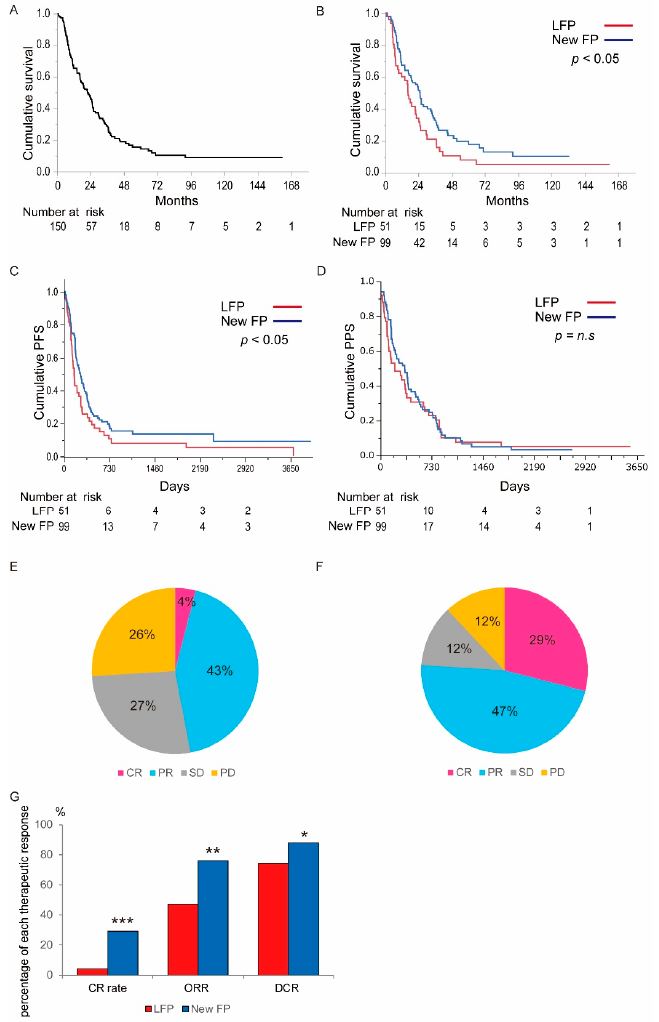
Figure 2. The therapeutic outcomes of LFP and New FP. ( A ) Overall survival curve of the 150 patients treated with either LFP or New FP. The MST of 150 patients was 21.8 months. ( B ) Comparison of the survival curve between LFP and New FP group. The MST of LFP group was 16.1 months. The MST of New FP was 24.7 months. There was a significant difference between two groups ( p < 0.05). ( C ) Comparison of Progression-free survival between LFP and New FP group. The PFS of LFP group was 5.4 months. The MST of New FP was 8.8 months. There was a significant difference be- tween two groups ( p < 0.05). ( D ) Comparison of the post-progression survival between LFP and New FP group. The PPS of LFP group was 6.8 months. The PPS of New FP was 11.5 months. There was no significant difference between two groups ( p = 0.411). ( E ) The therapeutic response of LFP group. In LFP group, CR, PR, SD, and PD were 4, 43, 27, and 26%, respectively. ( F )The therapeutic response of New FP group. In the New FP group, CR, PR, SD, and PD were 29, 47, 12, and 12%, respectively. ( G ) Comparison of the therapeutic response between LFP and New FP group. The